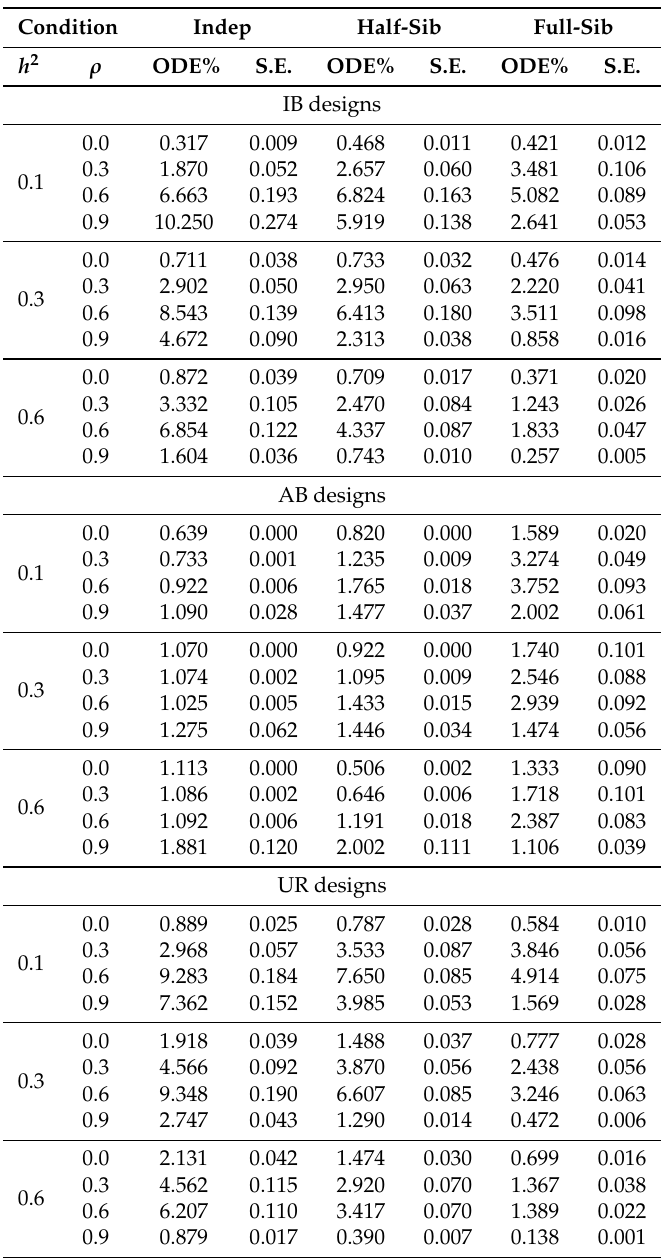
Table 2. Summary of average ODE% and their standard errors (S.E) for incomplete block (IB), unequally replicated (UR) and augmented block (AB) designs with varying genetic relatedness, spatial correlations ( ρ ) and narrow-sense heritability ( h 2 ) based on m = 100 initial designs, λ = 10 replicates per condition and p = 5000